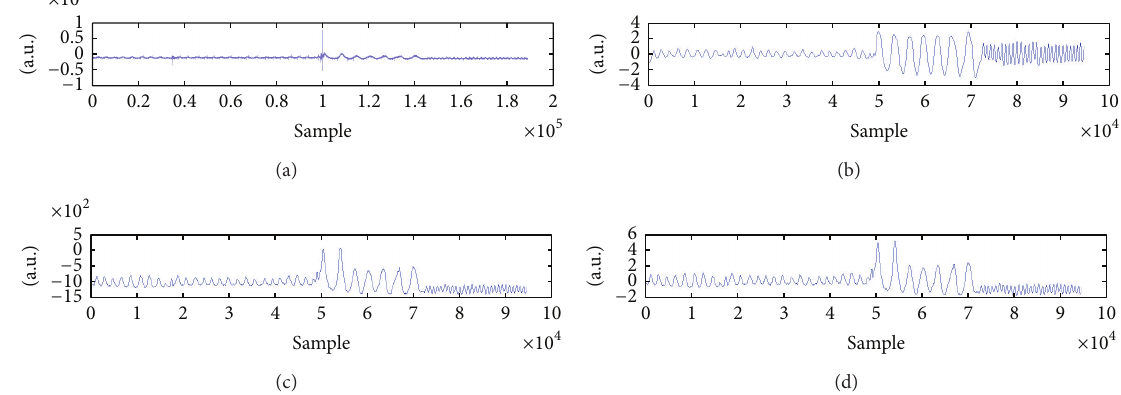
Figure 6: Process of extracting the ADR signal from the raw SCG